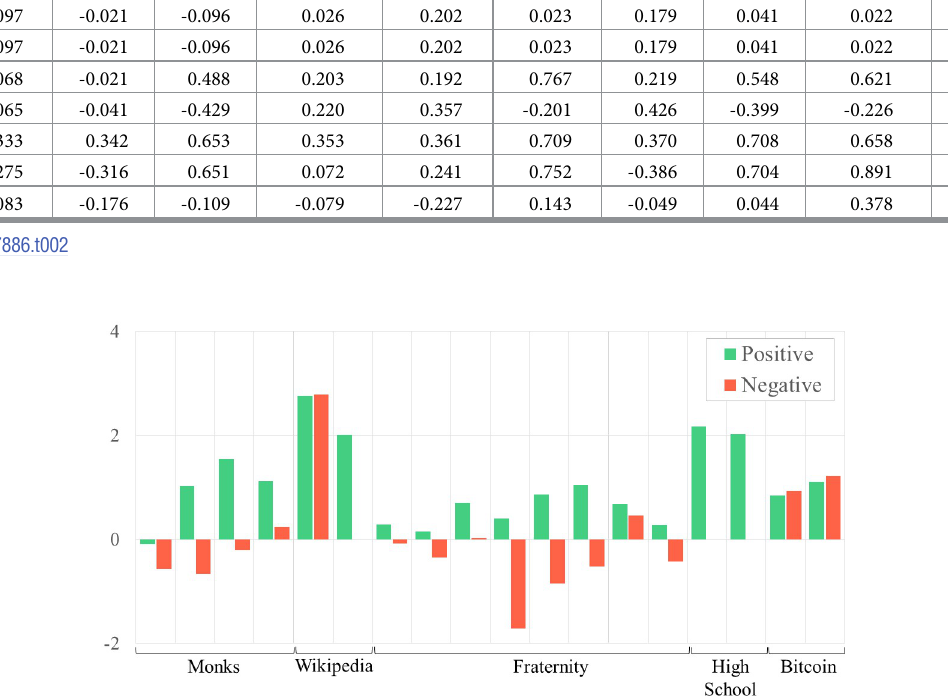
Fig 3. Transitivity ERGM coefficient values for positive versus negative networks grouped by network